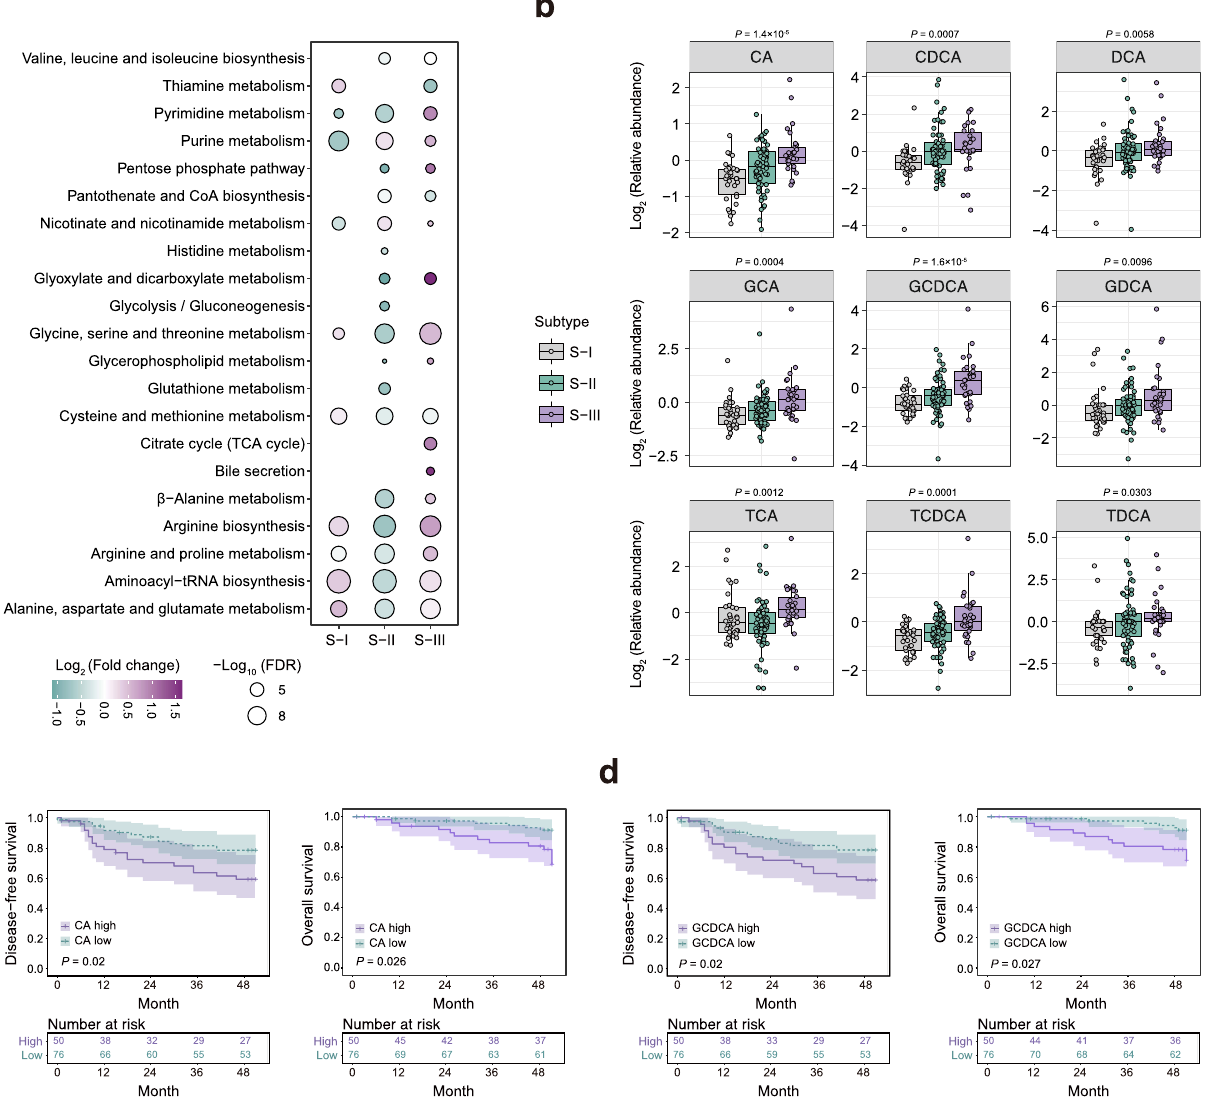
Fig. 5 Accumulation of bile acids in metabolic subtype III and its association of with clinical outcome. a KEGG metabolic pathways enriched by signi fi cantly differential metabolites (Two-sided Wilcoxon rank-sum test, FDR < 0.05) in each subtype relative to the other two metabolic subtypes. One- sided Fisher ’ s exact test followed by Benjamini-Hochberg (BH) multiple comparison test with FDR < 0.05. b Boxplots of the log 2 relative abundance of bile acids in three metabolic subtypes (S-I, n = 33; S-II, n = 63; S-III, n = 30). Two-sided Kruskal-Wallis tests were used. The centerline represents the median, and the box bounds represent the inter-quartile range. The whiskers span 1.5-fold the inter-quartile range. c , d Kaplan – Meier curves predicting the disease- free survival and overall survival of IAC patients strati fi ed by bile acid level with two-sided log-rank P value. The patients were divided into high and low groups by 0.4 quantile of the bile acids levels in IAC